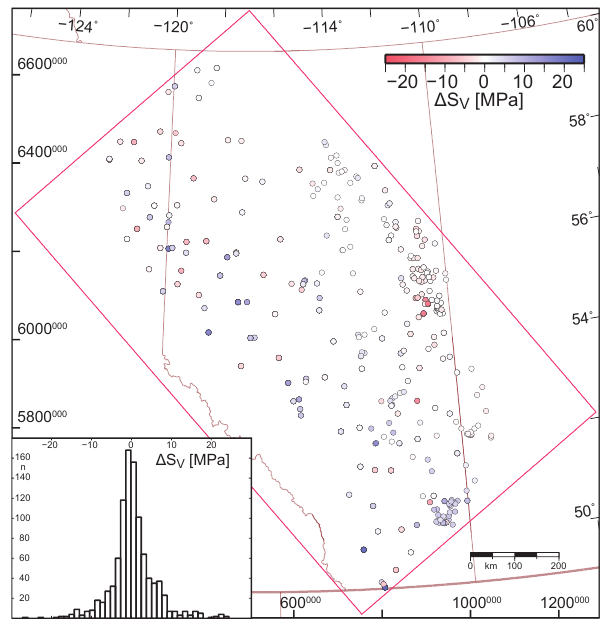
Figure 16. Spatial distribution of (cid:49)S V differences are plotted colour coded. The map extent is indicated by geographical coor- dinates (top and right) and by UTM coordinates from zone 11 (left and bottom).